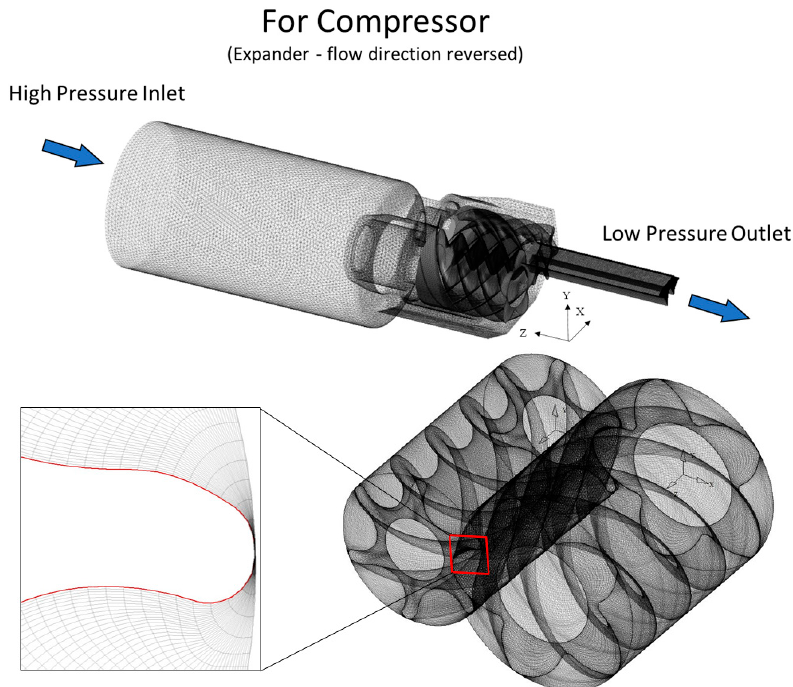
Figure 3. Mesh of fl uid domain and rotor screw.